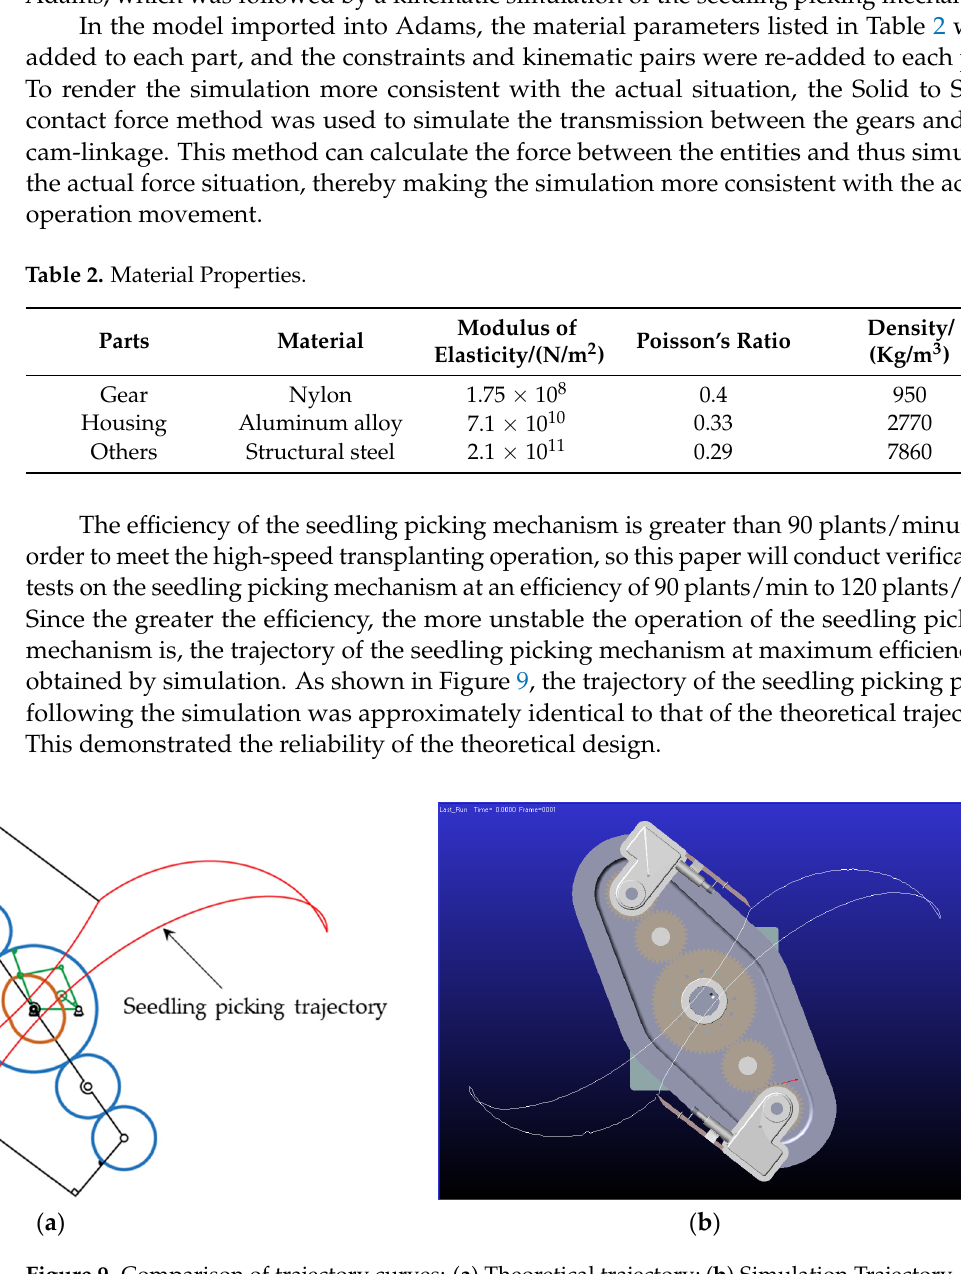
Figure 9. Comparison of trajectory curves: ( a ) Theoretical trajectory; ( b ) Simulation Trajectory.